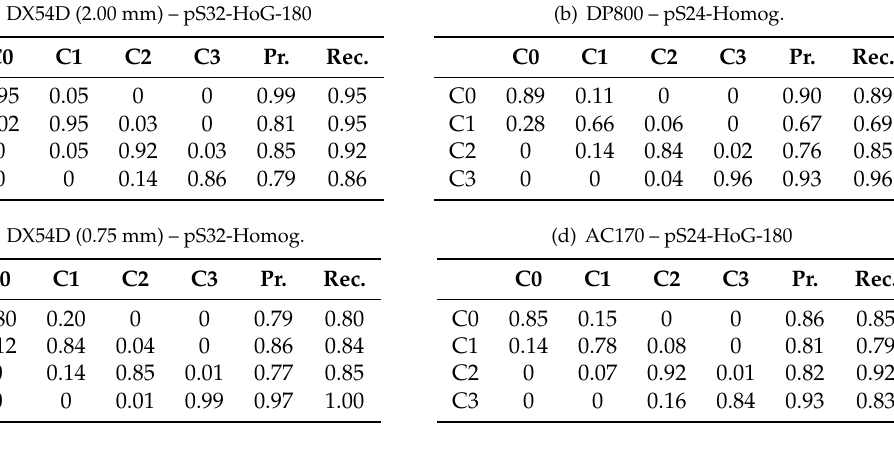
Table 4. Average error per sequence and class (in